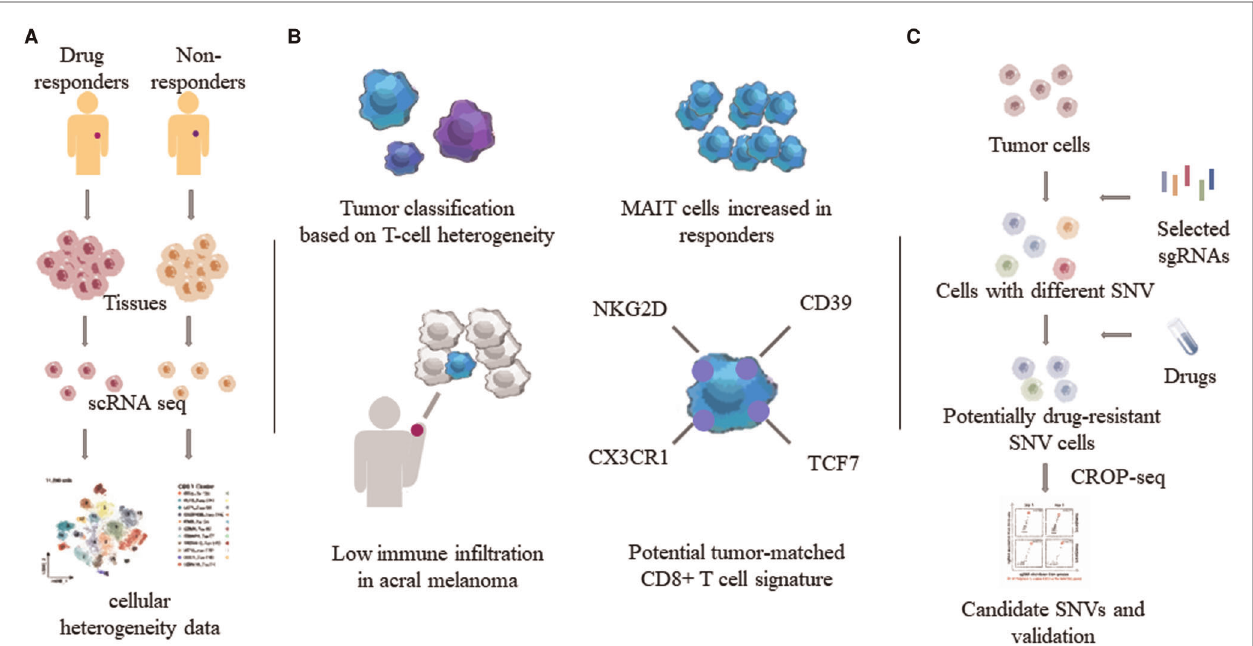
FIGURE 2 | Heterogeneity of tumor and immune cells by single-cell sequencing. Through single-cell sequencing of different tumor tissues and related tissues such as blood, the characteristics of different tumors and tumor-related immune cells, especially T cells, were obtained. ( A ) Determination of tumor heterogeneity using single-cell sequencing. ( B ) T cell properties in MM. MAIT: mucosa-associated invariant T cells. ( C ) One combination of the CRISPR/Cas system and single-cell sequencing. SNVs: single nucleotide